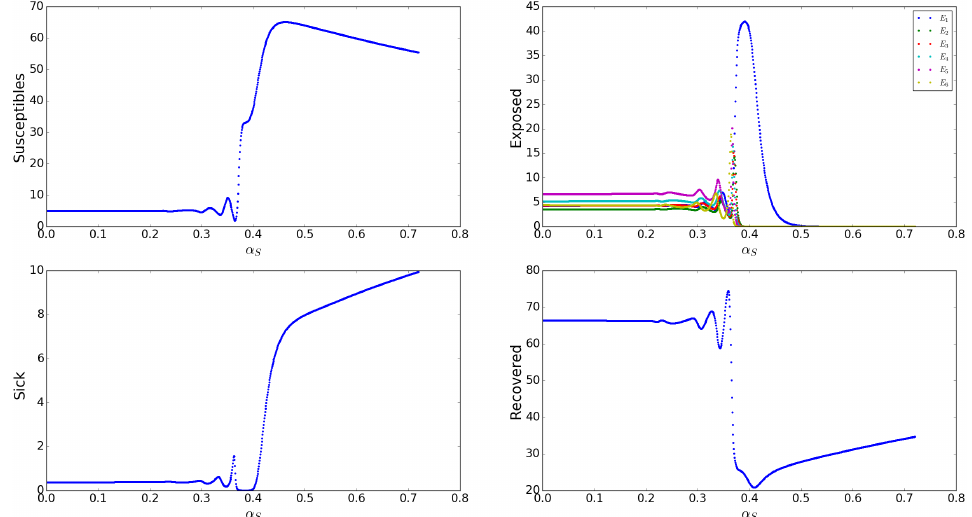
(cid:48) s (represented here by α S as in (A4)). i